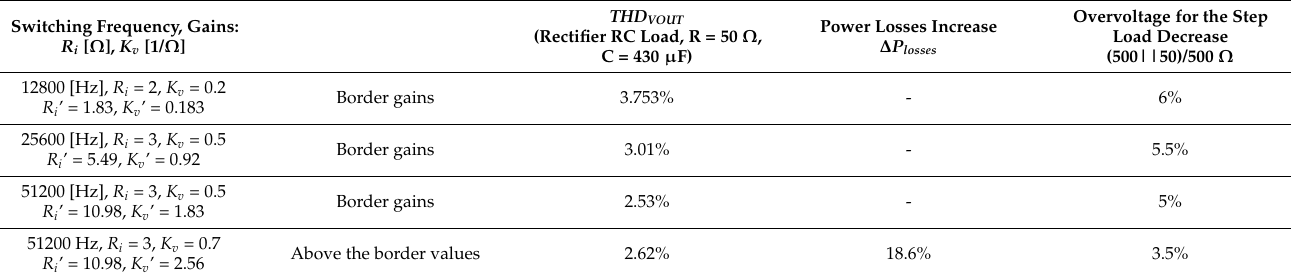
Table 2. Experimental results: Comparison of the parameters of the inverters output voltage with C F = 50 µ F, L F = 1 mH, R LF = 1 Ω , M = 0.5, RC load: R = 100 Ω , C = 430 µ F, dynamic loads (500||50)/500 Ω ). Switching Frequency, Gains: R i [ Ω ], K v [1/ Ω